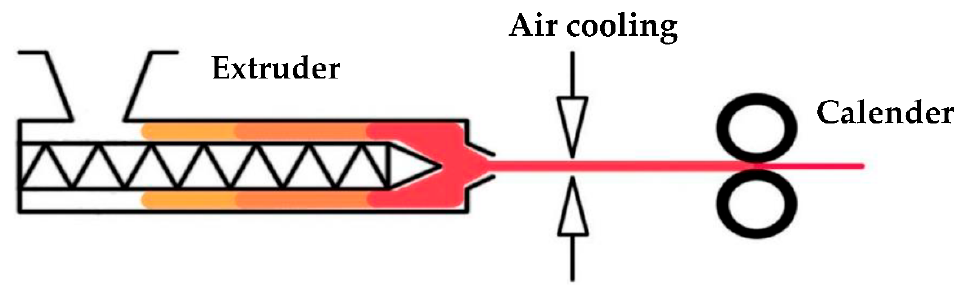
Figure 1. Scheme of precursor films manufacturing process.